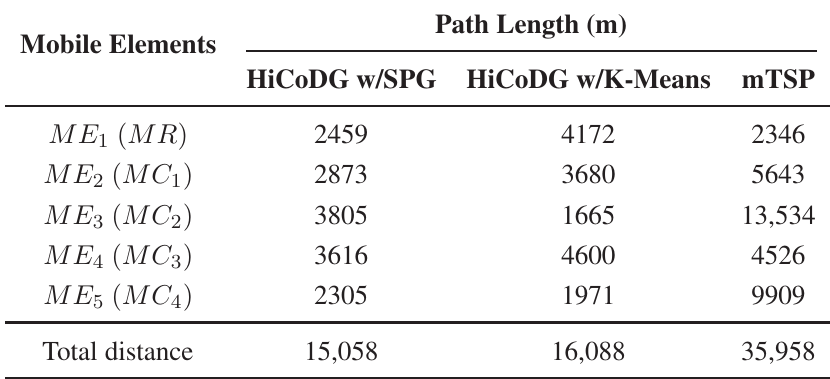
Table 3. Path length of Mobile